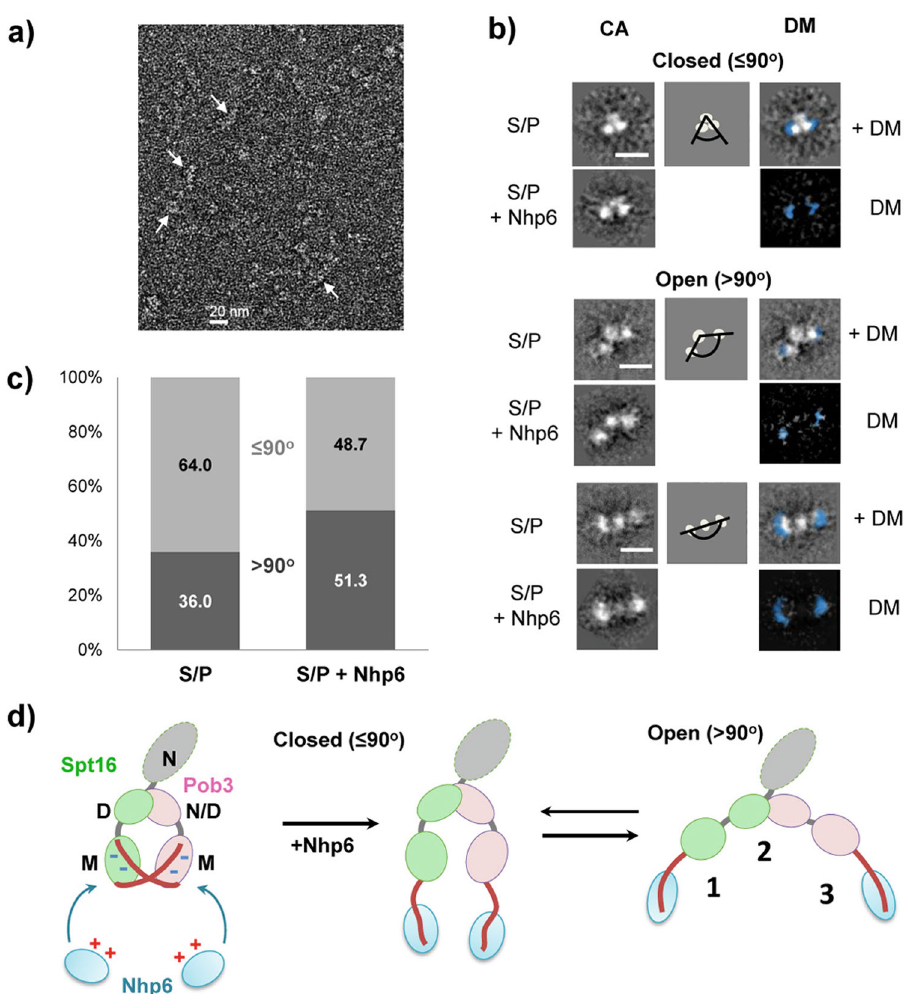
Fig. 2 FACT is a fl exible complex that is unfolded by Nhp6. a Representative images of Spt16/Pob3 obtained by transmission electron microscopy after negative staining. Arrows indicate single FACT particles. b Representative 2D class averages of Spt16/Pob3 with different arrangements of the three resolved densities in the presence/absence of Nhp6. Scale bar: 10 nm. CA class average, DM difference map. The complete set of 2D class averages is shown in Supplementary Fig. 4. c Quantitation of particles identi fi ed as closed ( ≤ 90°) or open (>90°) in samples with and without Nhp6. d Potential identities of the three resolved densities detected in class averages and a model for how Nhp6 promotes the formation of a more open form are shown. The gray oval on the scheme is the Spt16-N domain which was not resolved here or in the cryo-EM structures 21,54